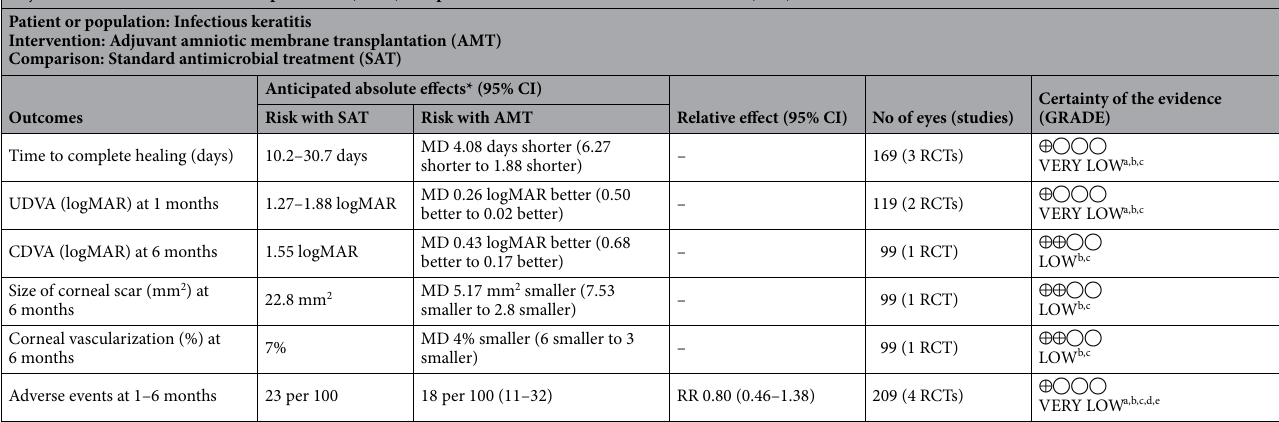
Table 3. GRADE summary of findings for various treatment outcomes of adjuvant amniotic membrane transplantation for infectious keratitis. GRADE Working Group grades of evidence. High certainty: We